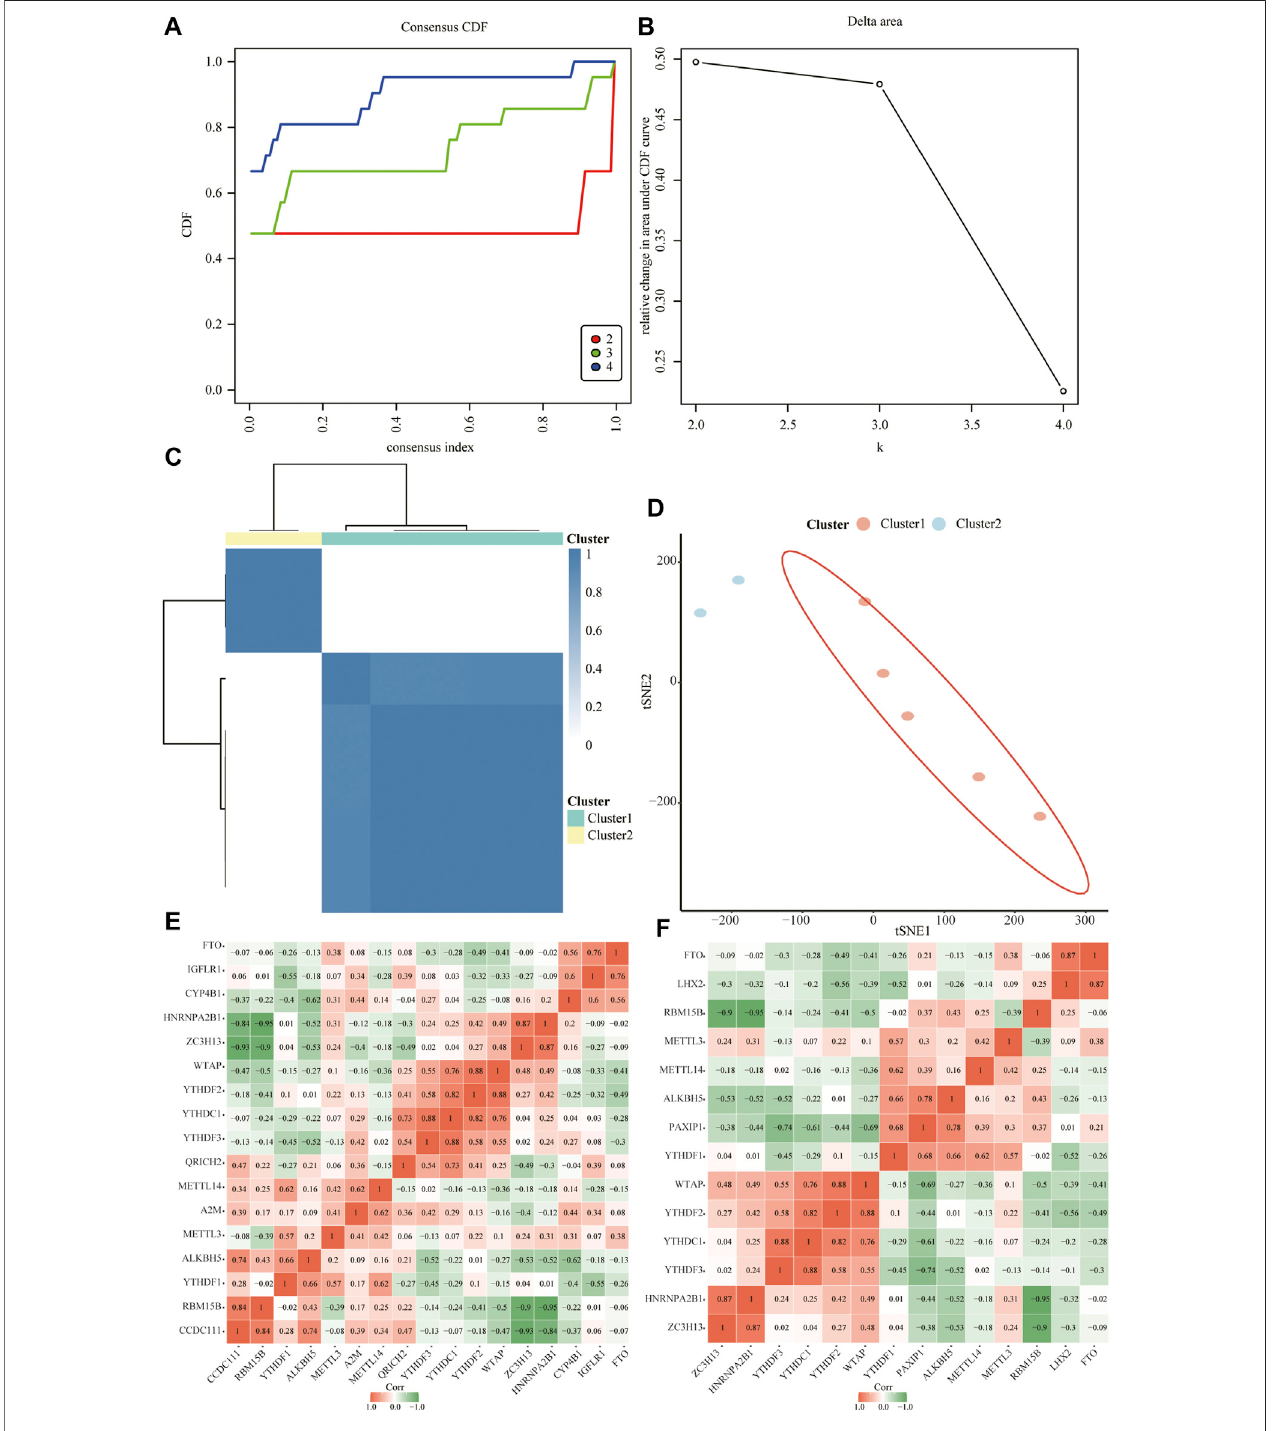
FIGURE10 | Relevant molecular subtypes and correlationsof depression. (A) Cumulative distribution function (CDF) curveof consensus clustering ofdepression- relatedmolecules;the abscissa isthe consensus index and the ordinate isthe CDF index. (B) Relative change inthe areaunder theCDF curve;the results show thatitis dividedintotwotypes,andthechangetrendisthemoststable. (C) Clusterheatmapofdepression-associatedmolecularsubtypes. (D) Principalcoordinateanalysisplot of depression-related molecular subtypes. (E) Heat map of the correlation between hub genes and isoform 1. (F) Heat map of the correlation between hub genes and isoform